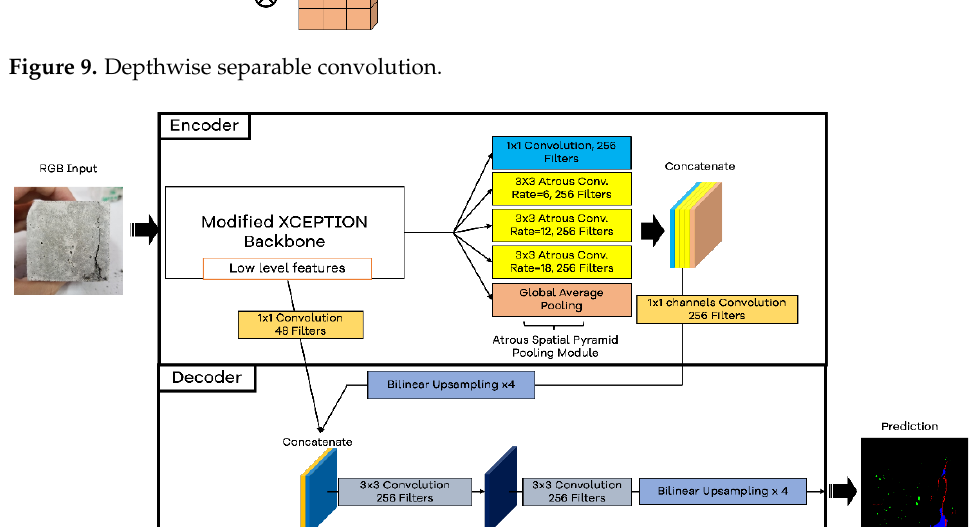
Figure 10. DeepLabV3+ architecture.